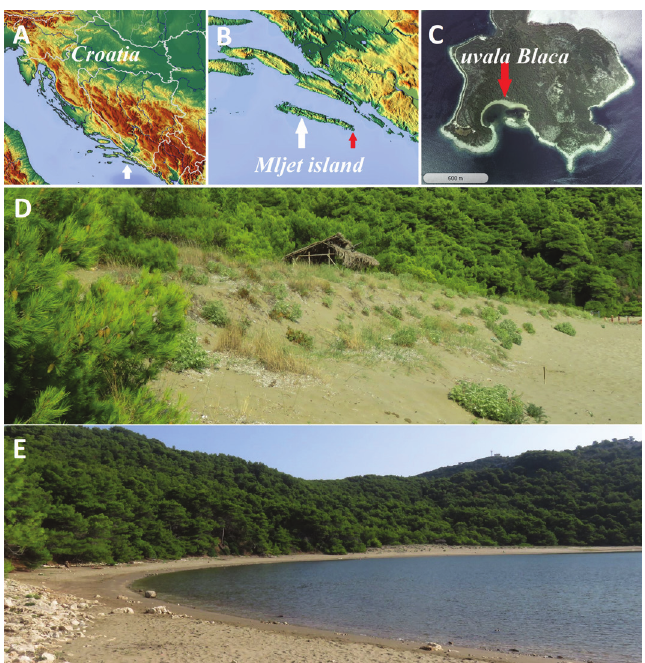
Fig. 1. Images of the study site: A–C. The location of Blace Bay in Croatia in the southeast of the island of Mljet; D. The psammo- phytic vegetation where the species was found; E. Blace Bay.